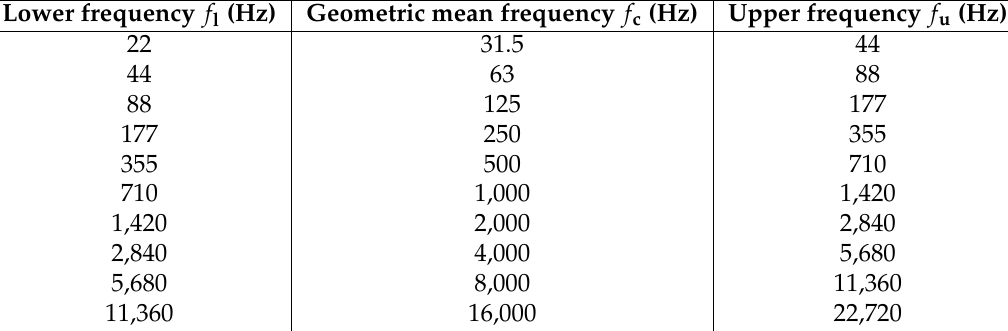
Table 1. Preferred octave frequency bands according to the ISO standard [61].